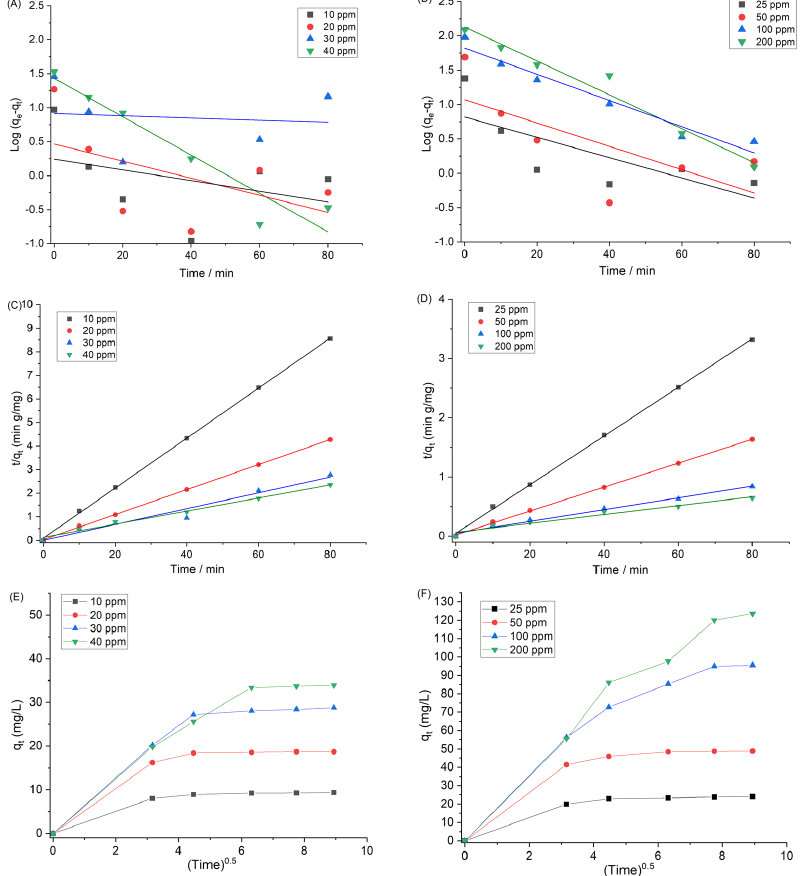
Figure 10. ( A , B ) Pseudo first ‐ order kinetics of Fl and CV, respectively. ( C , D ) Pseudo second ‐ order kinetics of Fl and CV, respectively. ( E , F ) Intraparticle diffusion kinetics for adsorption of Fl and CV, respectively. At 298 K. Table 4. Pseudo first ‐ order and pseudo second ‐ order parameters for the adsorption process at 298 K.